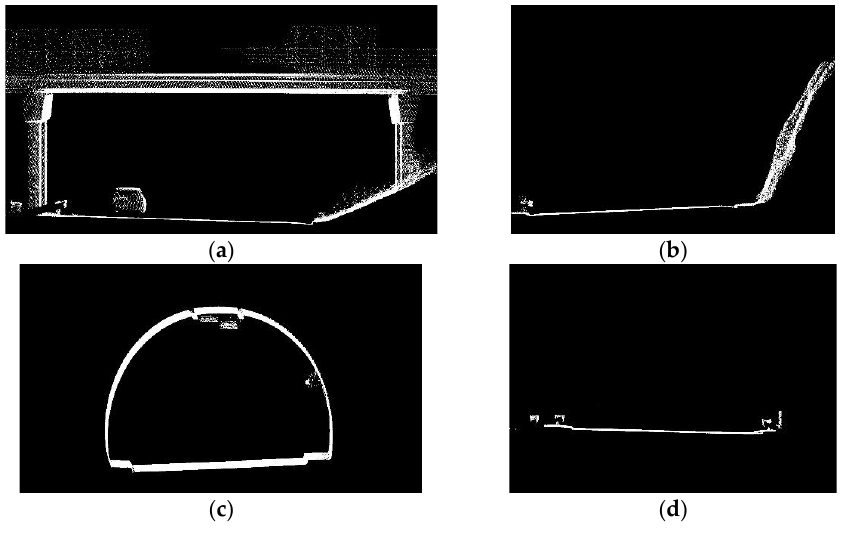
Figure 5. ( a ) Example of road cross section on part of road with overpass; ( b ) example of road cross section on part of road with irregular rockface; ( c ) example of road cross section on part of road with tunnel; ( d ) example of road cross section on part of road with both safety